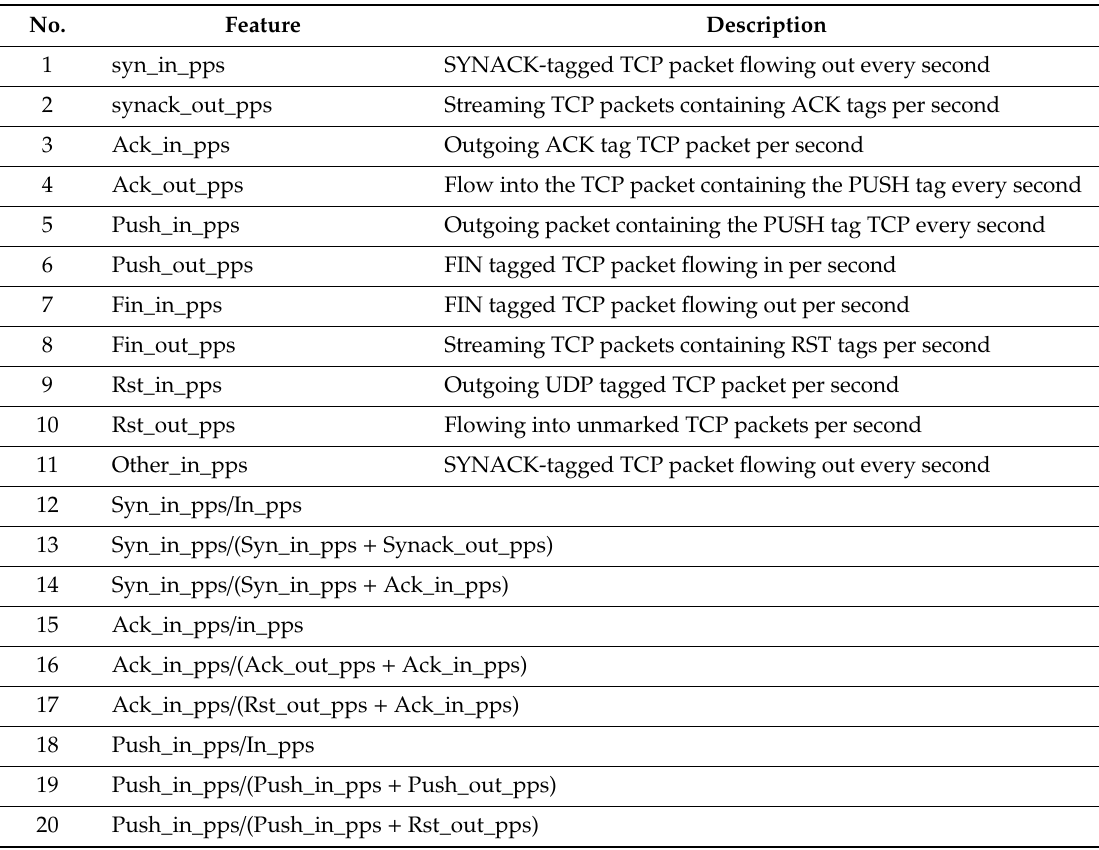
Table A1. Distributed denial of service (DDoS) attack